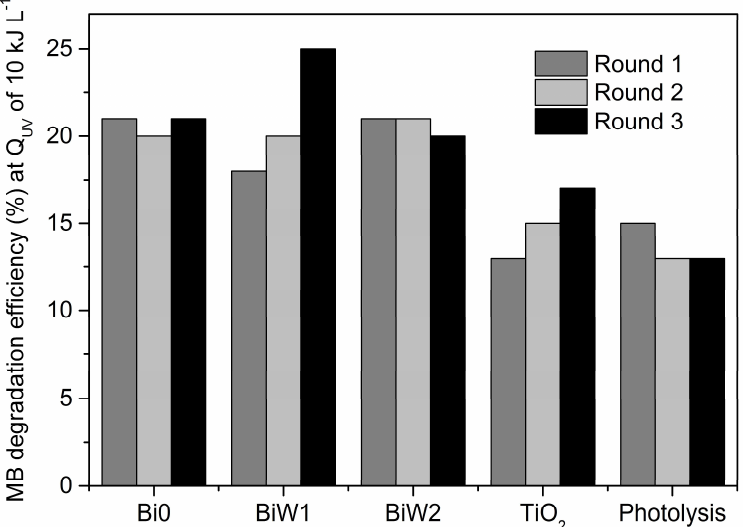
Figure 8. MB absorbance decay at 664 nm after 10 kJ L −1 of global accumulated UV irradiance (three rounds of use).